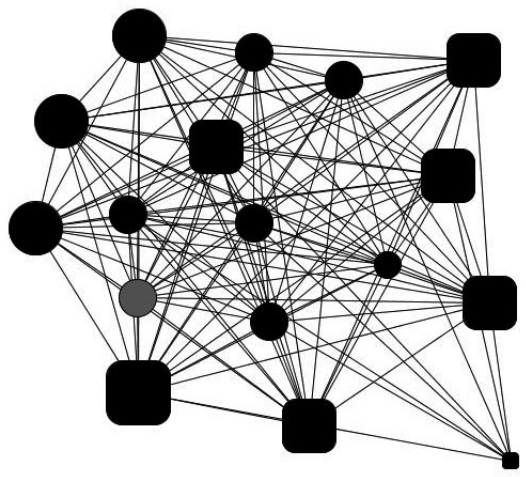
Figure 1. Encarna’s personal network. Notes: Node size indicates relational role—size 1 (biggest; closest family: parents, brothers/sisters, and sons/daughters), size 2 (in‐laws), size 3 (friends, neighbours), size 4 (distant relatives), size 5 (small‐ est; social worker, “others”); node shape indicates gender—circle (female), rounded‐square (male); node colour indicates proximity: black (“very close”), dark grey (“close”), light grey (“not very close”), white (“not close at